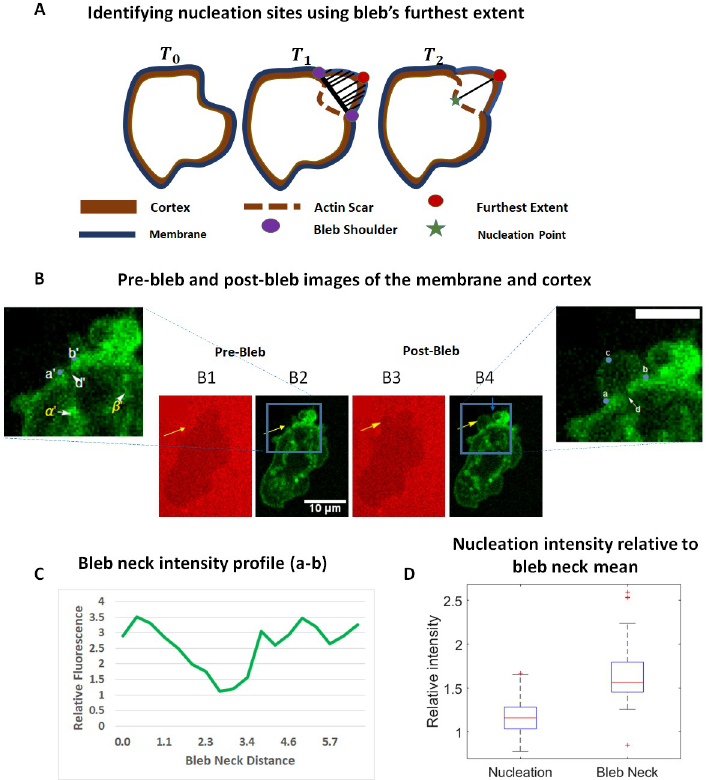
Fig 2. The furthest extent of the bleb identifies nucleation sites. A) A cartoon of a cell before bleb initiation (prior cell, T 0 ) initiates and stabilizes a bleb at time T 1 (post cell). The perpendicular distance between points on the fully formed bleb and a line segment connecting the bleb shoulder points (bleb neck) is used to determine the furthest extent as shown by black lines. In T 2 the furthest extent is projected onto the actin scar to identify the nucleation point. B) Pre-bleb (B1,B2) and post-bleb (B3,B4) images of a chemotaxing D. discoideum cell expressing lifeAct GFP with membrane images (B1,B3) and cortex images (B2,B4). Enlarged portions of the cortex images are shown to clearly identify the location of the gap. The yellow arrows point to the location of the bleb. The locations α 0 and β 0 in the pre- bleb image point to actin structures that are also present in the post-bleb images. In the post-bleb image, the furthest extent, location c , is applied to identify nucleation site, location d , where a visible gap is seen. The shoulder points are identified by a , b . Scale bar is 5 um. C) The relative intensity of F-actin in the actin scar of the post-bleb image is shown. The gap here corresponds to a local minimum of 1.1. D) Local minima of intensity measurements at the nucleation sites for 39 blebs is compared with the average intensity at the bleb neck. Difference in medians is significant (Kruskal-Wallis test, p − value <